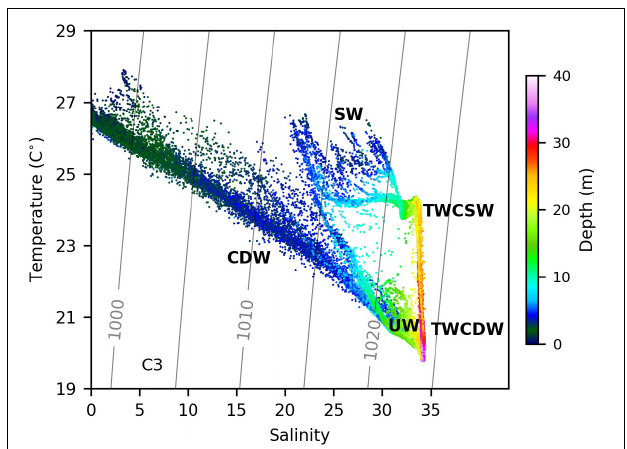
FIGURE 5 | The temperature-salinity diagram from measurements on Transect C2. CDW, TWCSW, TWCDW, UW, and SW denote the Changjiang diluted water (or the plume water), the Taiwan Warm Current surface water, the Taiwan Warm Current deep water, the upwelled water and the ambient surface water, respectively. Color represents the depth of each measured